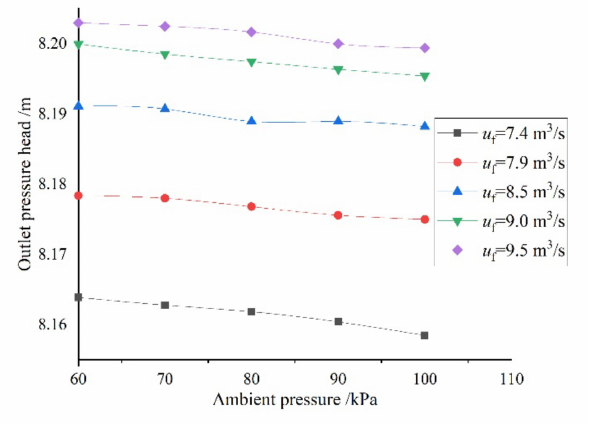
Figure 9. Fan outlet pressure head under di ff erent ambient pressure.